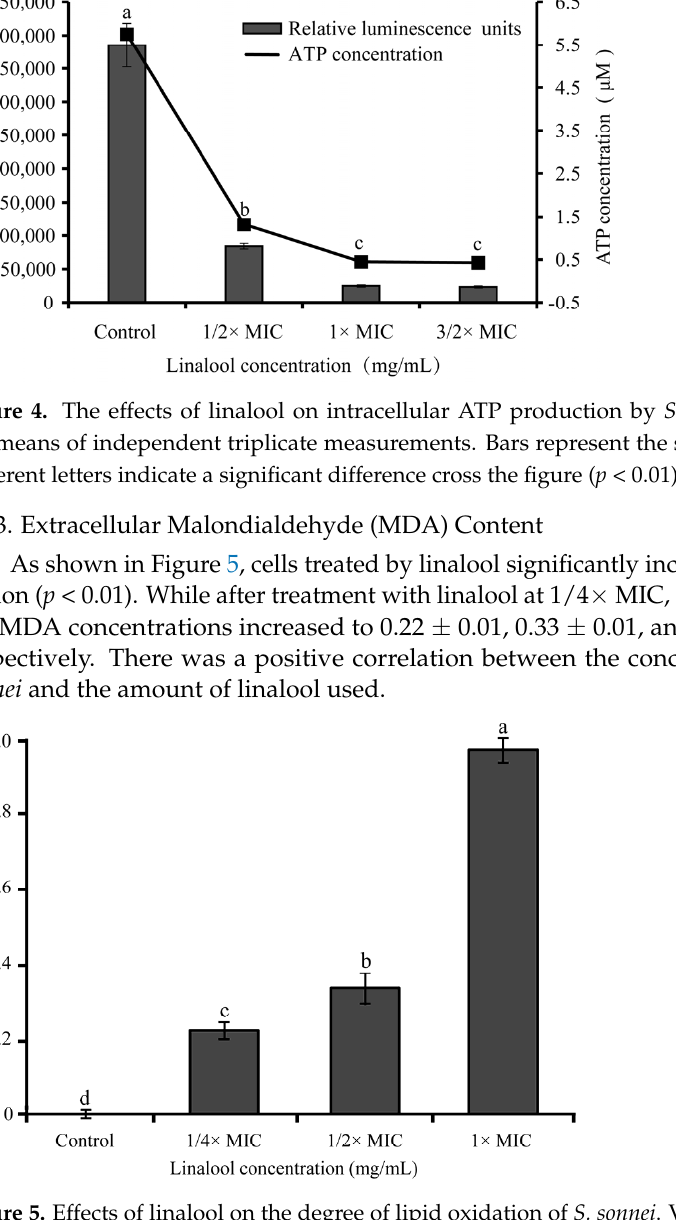
Figure 5. Effects of linalool on the degree of lipid oxidation of S. sonnei . Values represent the means of independent triplicate measurements. Bars represent the standard deviation ( n = 3). Different letters indicate a significant difference cross the figure ( p < 0.01).